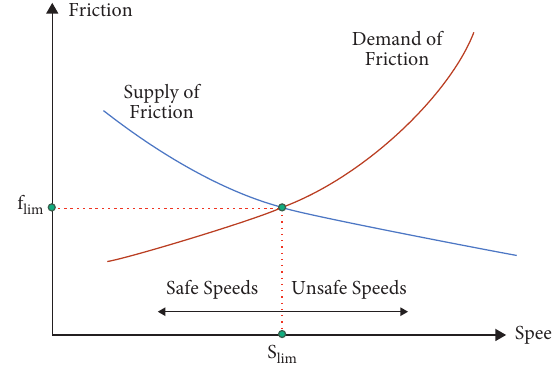
Figure 1: Relationship between existing friction and required friction in a circular horizontal curve